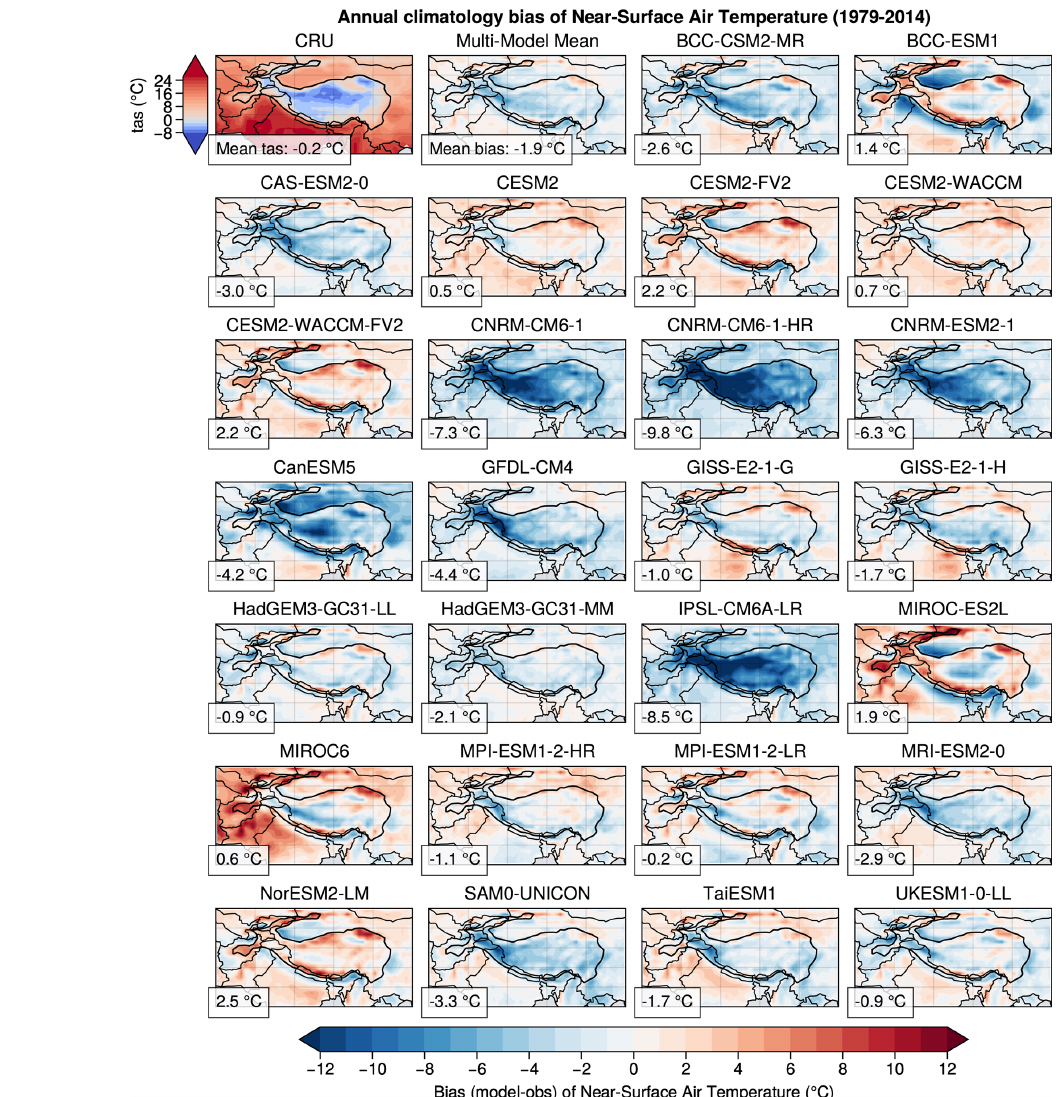
Figure 3. Annual bias (model minus observation) computed over 1979–2014 for temperature, except the top left panel that shows the climatology estimated from the CRU observation, used as the reference for the bias computation. The panel located at the right side of the CRU observation shows the bias of the multimodel mean based on the 26 models shown in the figure. The black contour shows the political frontiers and the bold black line the HMA domain located above 2500ma.s.l., for which the spatial average of the bias is given in the bottom left of each